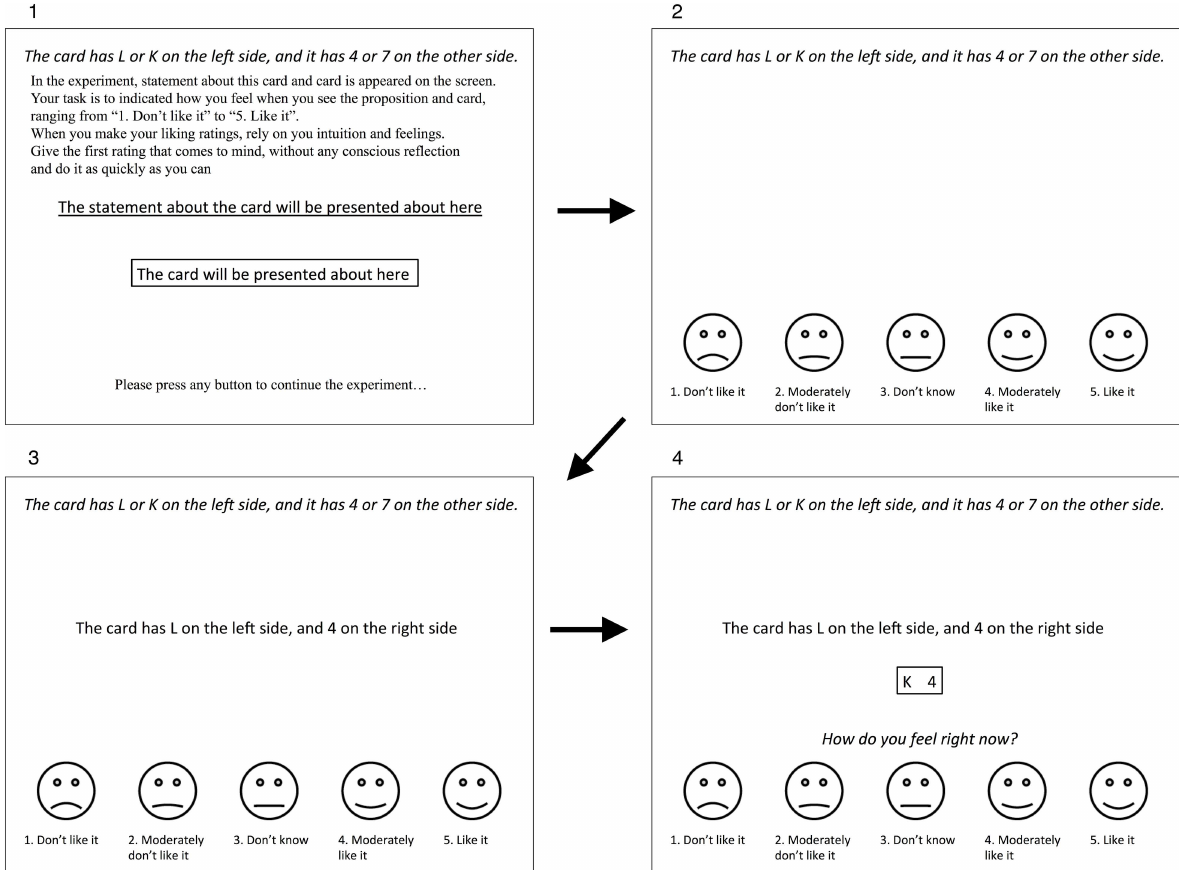
Fig 1. Example of the Liking Rating Task in Experiment 1 (Conjunctive Form and FT